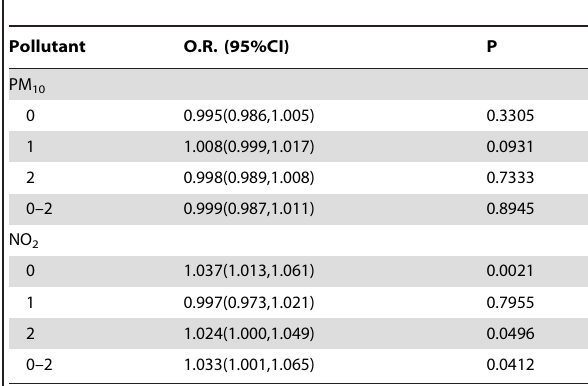
Table 4. Relationship between stroke and PM 10 and NO 2 concentrations in a two-pollutant model in the cold season for 10 m g/m 3 increases in pollutant level, adjusted for temperature and